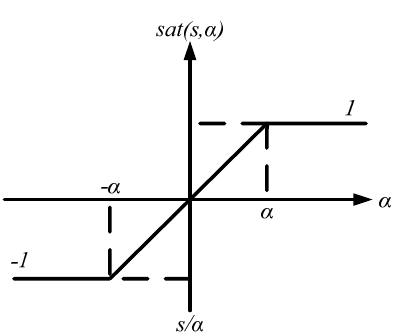
Figure 7. Concept of the sliding layer.